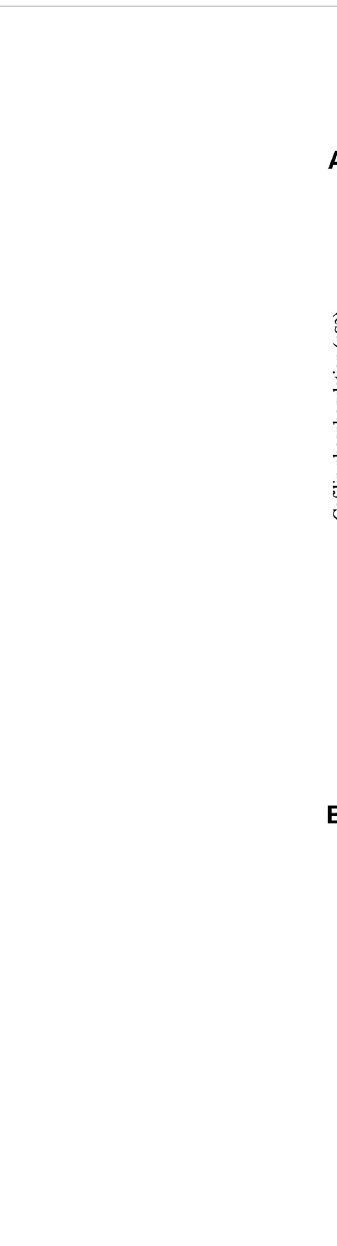
FIGURE 1 Ability of various pancreatic acinar secretagogues and dose-response effect of cholecystokinin (CCK)-8 and CCK-JMV to stimulate co fi lin in rat pancreatic acini. (A) Isolated pancreatic acini wereincubatedintheabsenceorpresence ofCCK-8 (100 nM), carbachol (1 μ M),bombesin(1 nM), secretin (1 nM) or VIP (1 nM) for 1 min and then lysed. (B) Isolated pancreatic acini were incubated in the absence or presence of CCK-8 and CCK-JMV (at the indicate concentrations) for 3 min and then lysed. Western blots were analyzed using anti-pS3 co fi lin, which mediates the activation state of co fi lin. Bandswerevisualized usingchemiluminescenceand quanti fi edbydensitometry. Top :Results of arepresentative blotofthree independentexperiments are shown. Bottom : Means ± S.E. of at least 3 independent experiments. Results are expressed as % of basal stimulation of the control group. *, p < 0.05 compared to the control